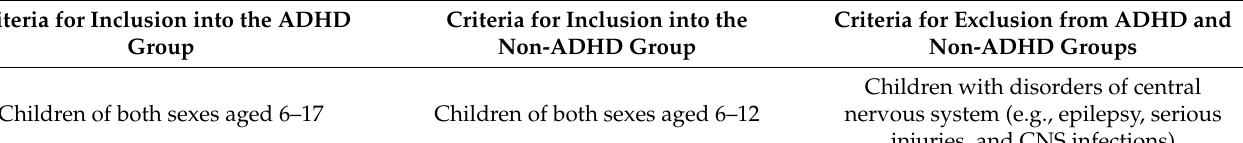
Table 1. Inclusion and exclusion criteria for ADHD and non-ADHD